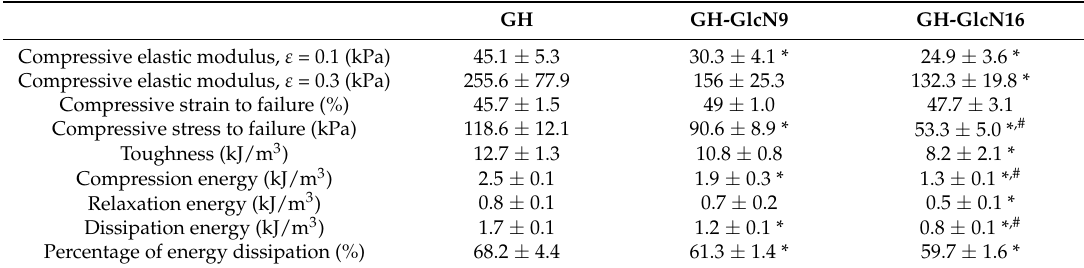
Figure 4. The compressive mechanical properties of GH, GH-GlcN9 and GH-GlcN16 cryogels. ( a ) Stress-strain curve; ( b ) stress relaxation at 30% strain. The viscoelastic properties of cryogels determined by dynamic compression testing at 30% strain are shown as storage modulus ( E ′ ) and loss modulus ( E ′′ ) ( c ); and loss tangent (tan δ ) ( d ). Table 2. Mechanical properties of GH, GH-GlcN9 and GH-GlcN16 cryogels. Values are mean ± SD of five independent measurements.